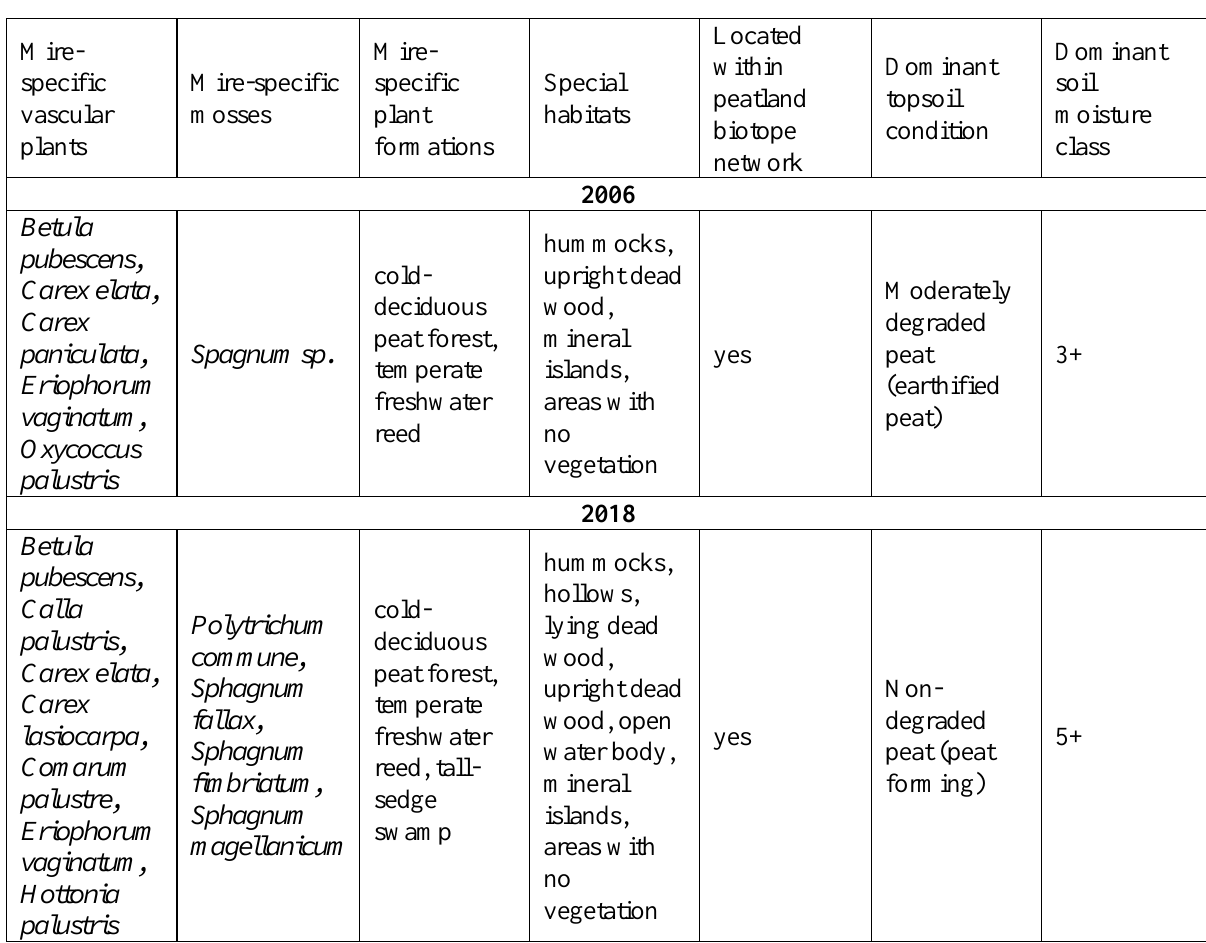
Table 13. Overview of mire-specific biodiversity components at ‘Großes Brennbruch” in the years 2006 (before restoration) and 2018 (after